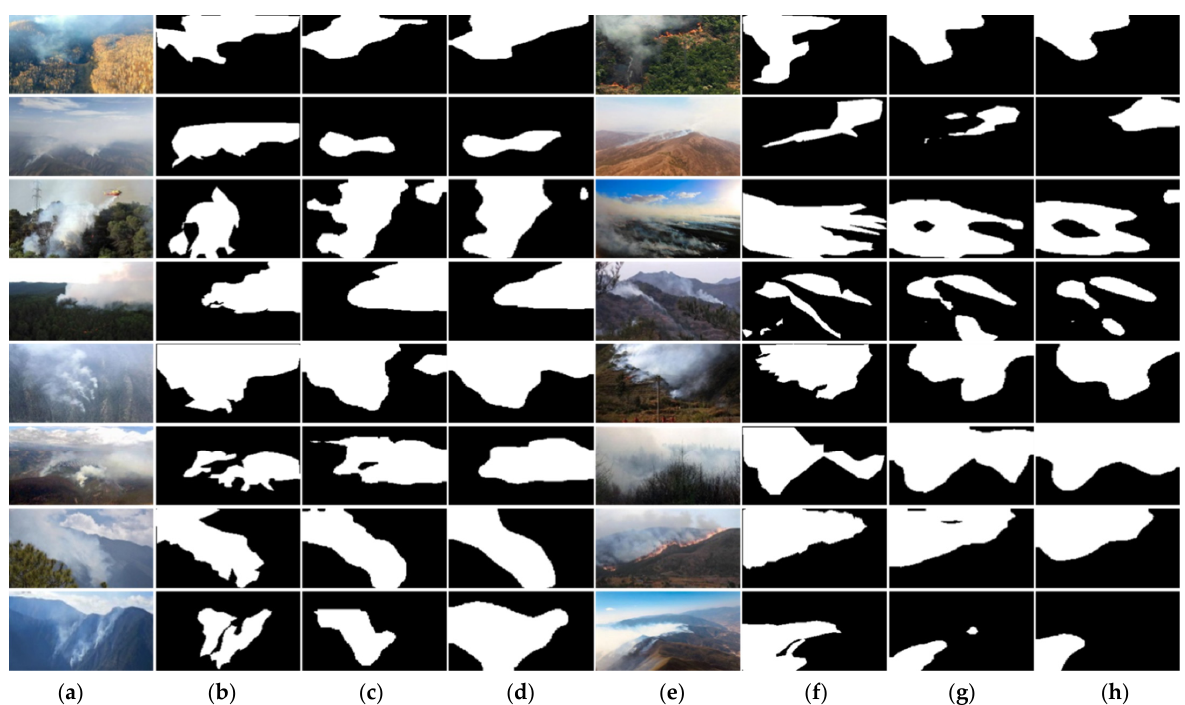
Figure 5. Comparison of segmentation results. ( a , e ) The original image. ( b , f ) GT image. ( c , g ) Unweighted. ( d , h ) Segmentation with λ -MAE-0.1.